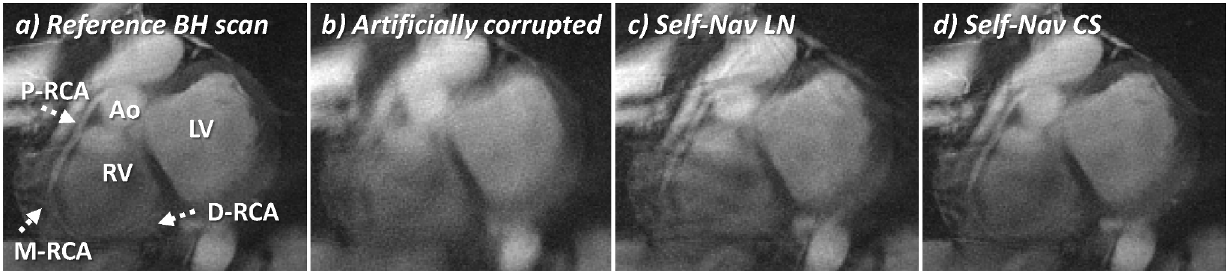
Figure 3. In vivo motion correction simulation. On the targeted acquisition of the right coronary artery (RCA), the following anatomical structures are visible: left ventricle (LV), right ventricle (RV), aorta (Ao), proximal (P), mid (M) and distal (D) segments of the RCA (dotted arrows). To test the performance of the self-navigation (Self-Nav) techniques, an RCA image was acquired during a breath-hold (BH) and serves as the reference standard of optimal respiratory motion suppression (a). In vivo respiratory displacement parameters were extracted at the level of a heart from a free- breathing acquisition in a healthy volunteer. These data were then used to corrupt each interleave of the standard of reference BH data simulating respiratory motion (b). These artificially corrupted data were then retrospectively corrected with the Self-Nav techniques using linear (c) and compressed sensing (CS) (d) reconstruction of the sub-images. While much of the blurring is suppressed with the Self-Nav LN method (c), residual streaking artifacts remain visible. Improved image quality and anatomy depiction were instead obtained with the Self-Nav CS method (d). This also provided more accurate motion detection, as evidenced by a 76% decrease of the error between the estimated displacements and the ground truth.